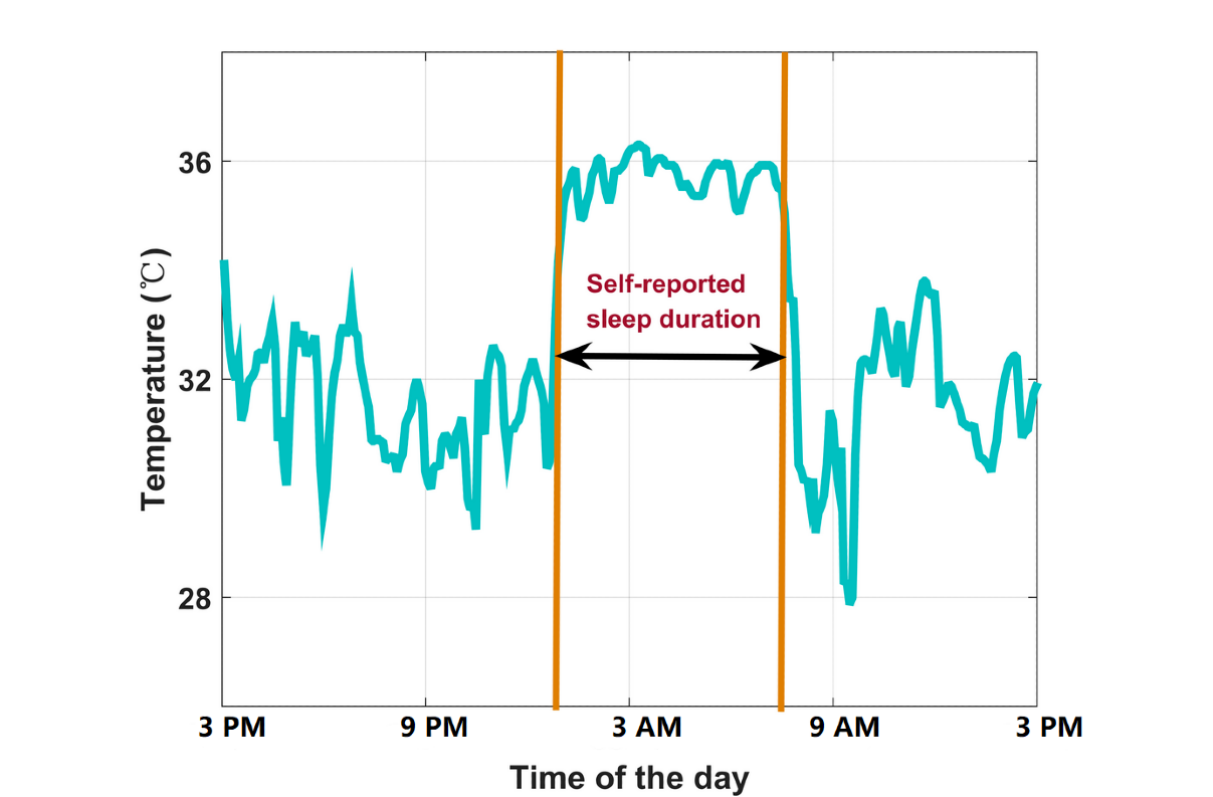
Figure 1. Example wrist temperature over a 24-hour period for a healthy sleep